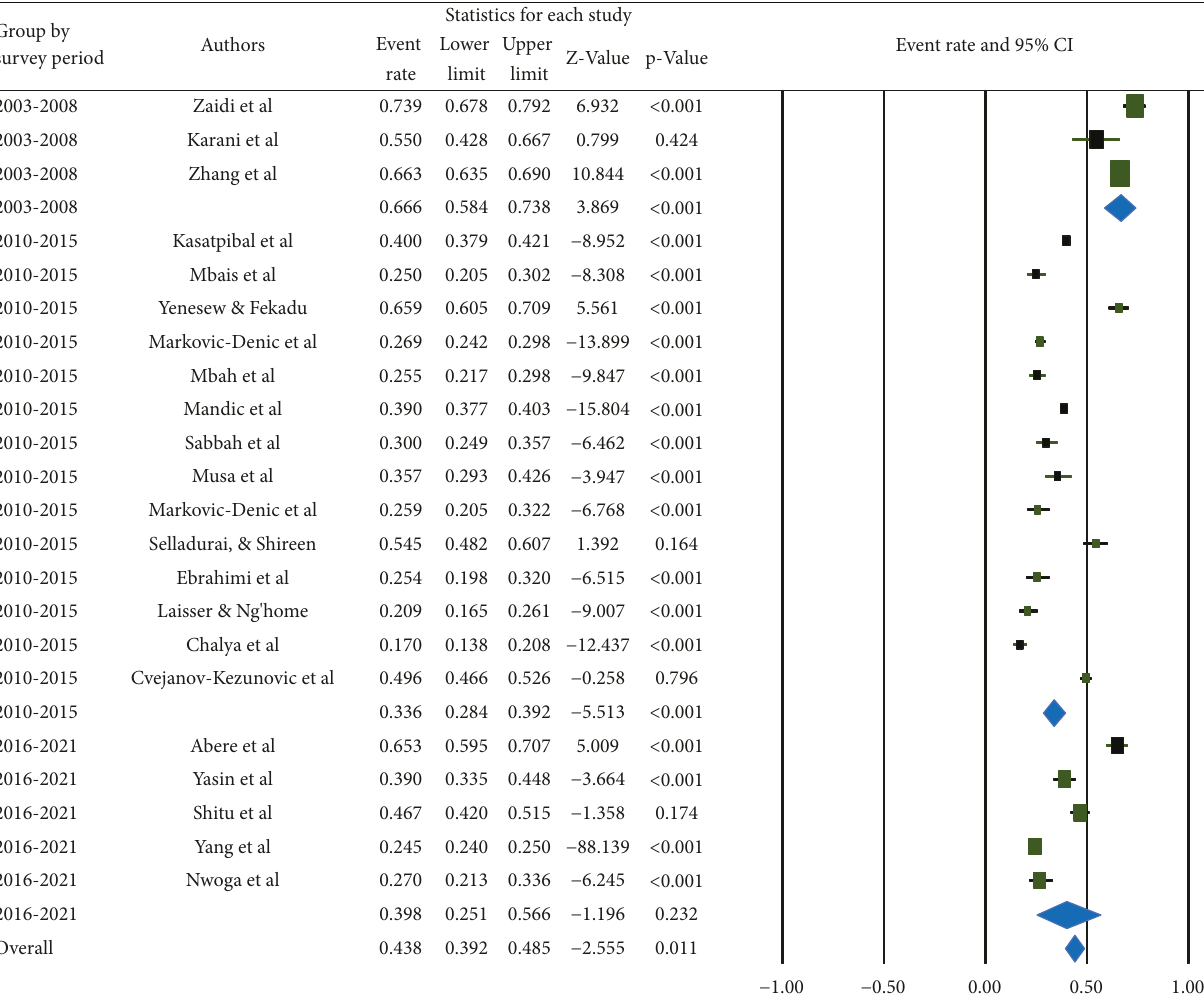
Figure 4: Pooled prevalence of occupational exposure to blood and body fluids in last 12 months among healthcare workers based on the survey